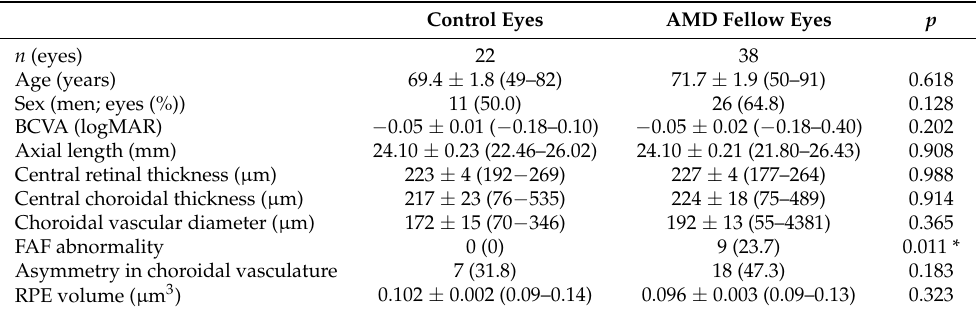
Table 1. Characteristics of the control and age-related macular degeneration (AMD) fellow eyes. Control Eyes AMD Fellow Eyes p n (eyes)